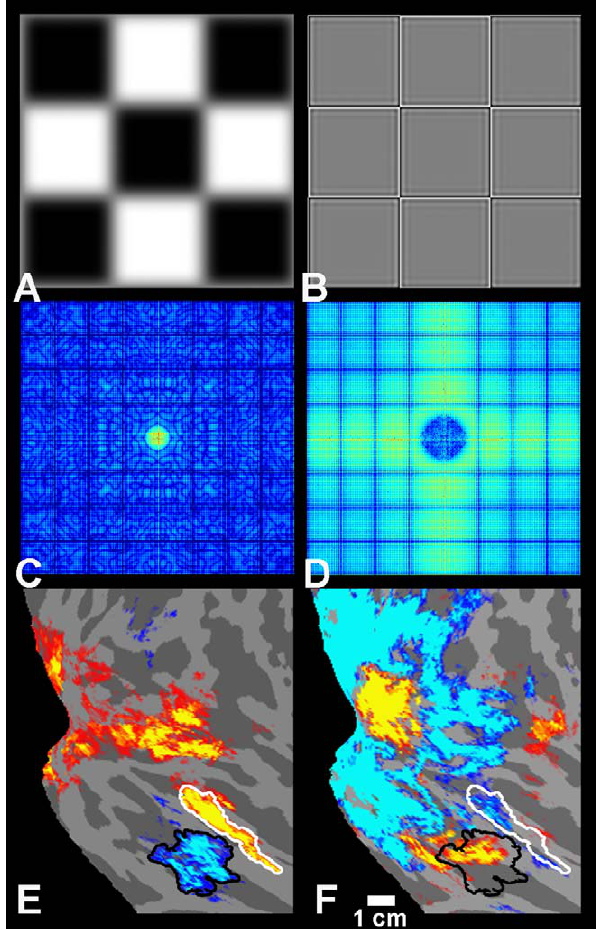
Figure 3. High-pass-filtered checkerboard images selectively activate PPA. (A and B) Examples of low SF (A) and high SF (B) checkerboards. In the actual experiment, an array of 6 6 6 checks was used, and the phase of the stimulus was systematically varied (see Materials and Methods for further details). The border around the stimuli is for illustration purposes only. (C and D) The FFTs of low SF (C) and high SF (D) checkerboards. The color map represents the FFT magnitude in Fourier space (see Figure 1A for more details about FFT maps). (E) The comparison between faces and places (an independent localizer scan) showed the classical areas FFA and PPA in the averaged map of four human subjects. The group-averaged activity map is displayed on a flattened view of the right occipito-temporal cortex. (F) The comparison of activity between high SF (yellow/red) and low SF (cyan/blue) checkerboards revealed a high SF bias within PPA. If anything, the opposite bias was found in parts of FFA. The maps are significant at the threshold of p , 10 2 2